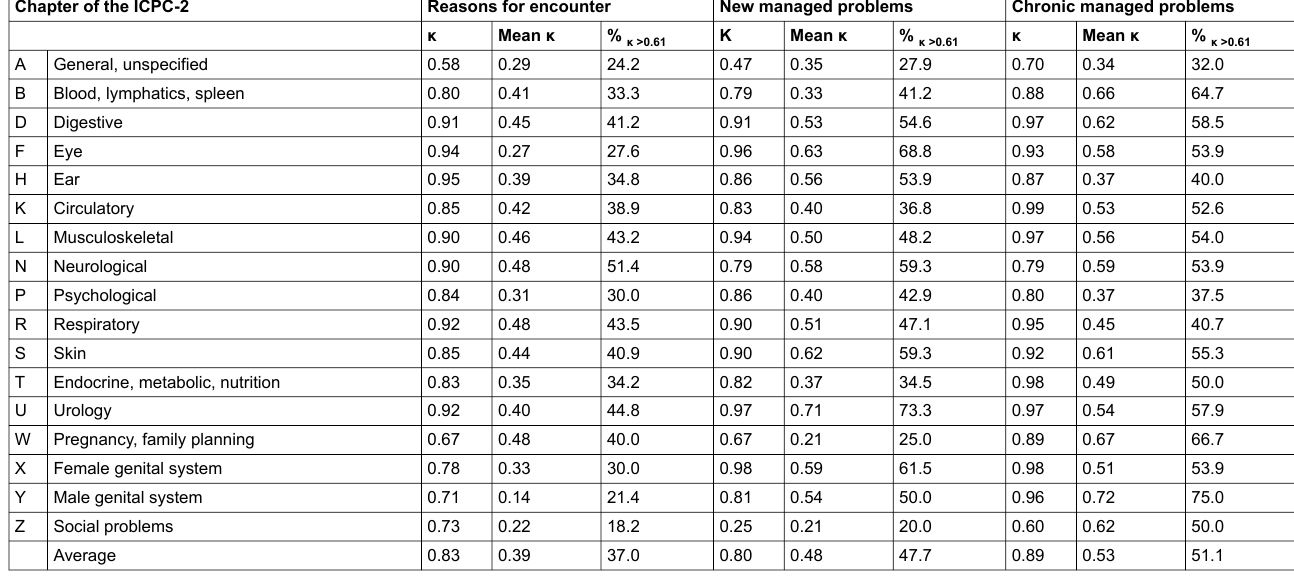
Table 2: Inter-rater reliability towards for reasons for encounter, new and chronic problems presented in Cohens Kappa on chapter level (κ), on single code level mean Kappa over all used codes (mean κ) and frequency of codes with good or very good Kappa (>0.61; % κ >0.61 ). Chapter of the ICPC-2